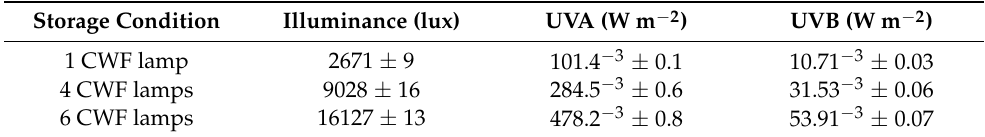
Table 2. Measurements of illuminance (lux) and irradiance in the UVA and UVB regions (W m − 2 ) recorded by digital handle photo-radiometer (values are mean of five